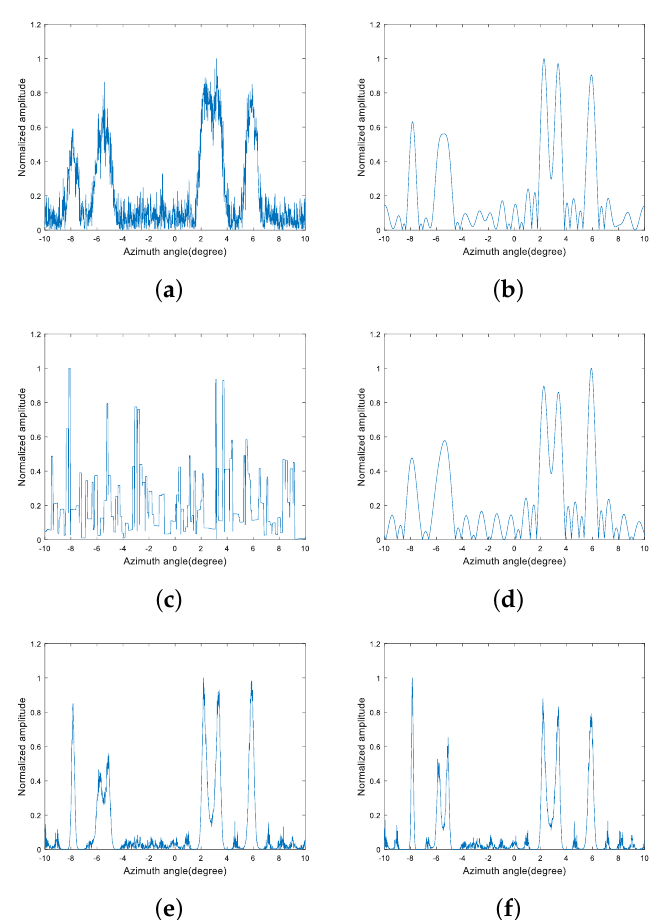
Figure 3. RBM echo and super-resolution processing results using different methods. ( a ) RBM raw echo in SNR = 10 dB. ( b ) The processing result using the REGU method. ( c ) The processing result using the TV method. ( d ) The processing result using the TSVD method. ( e ) The processing result using the PML method. ( f ) The processing result using the IPML method.